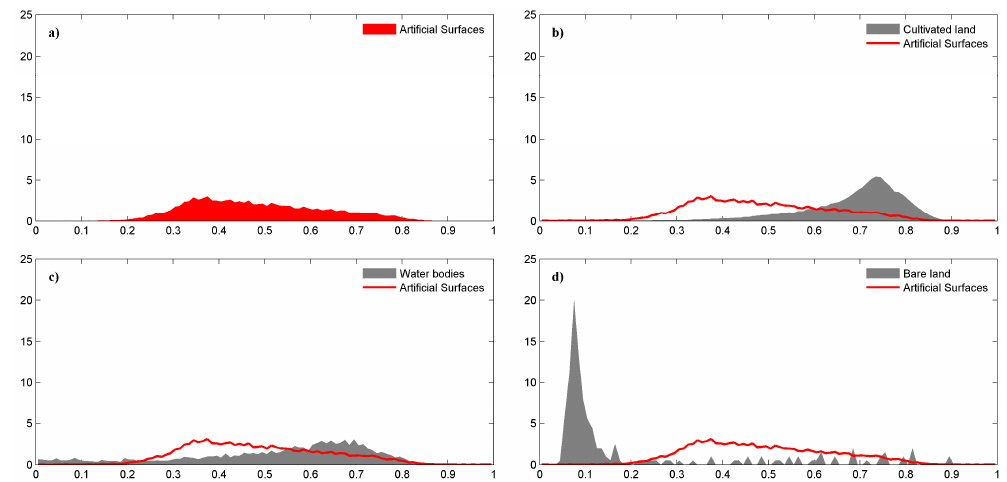
Figure 10. The distribution frequencies of the NDVI value of four easily confused land cover types: ( a ) artificial surfaces, ( b ) cultivated land, ( c ) water bodies and ( d ) bare land. The x -axis is the maximum NDVI value in 2012, and the y -axis is the distribution frequency.